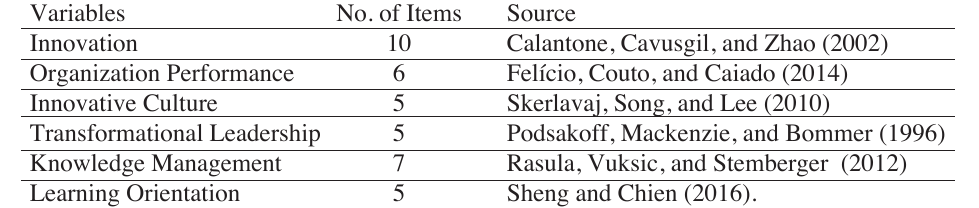
Table 1. Sources for Measurement Scale